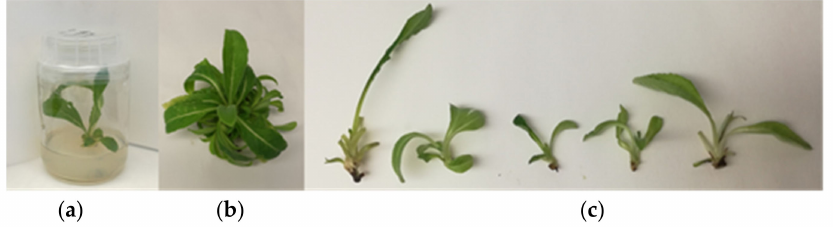
Figure 2. ‘Troianella‘ landrace artichoke: ( a ) Plantlet on culture initiation medium after 3 weeks; ( b ) plantlet after 3 weeks on proliferation medium; ( c ) five (5) new plantlets ready for the second